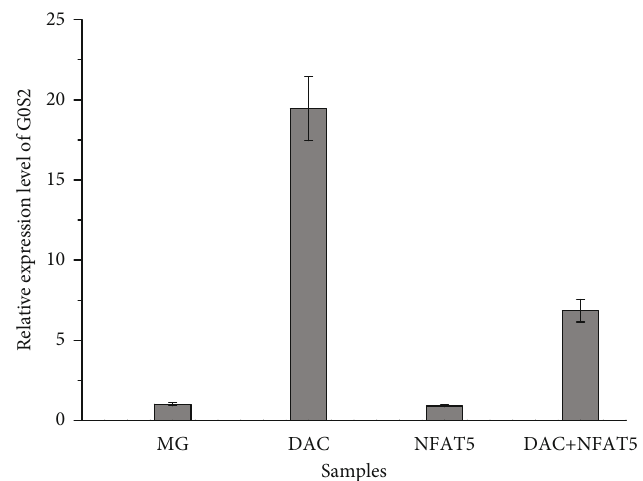
Figure 8: The expression level of G0S2 in the PMBC with di ff erent treatment. MG means the PMBC sample from myasthenia gravis patients; DAC means PMBC sample cocultured with DAC(5-aza-dC) to perform DNA demethylation. NFAT5 means PMBC sample which was transfected with P-EGF-N1-NFAT5 plasmid; DAC+NFAT5 means PMBC sample which were transfected with P-EGF-N1-NFAT5 plasmid after coculturing with